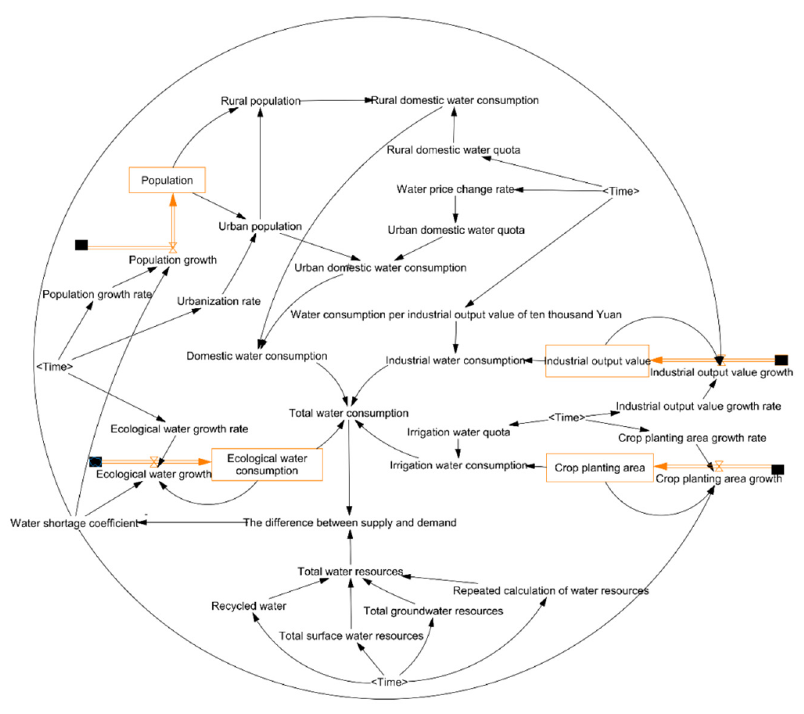
Figure 2. Flow diagram of SD model.